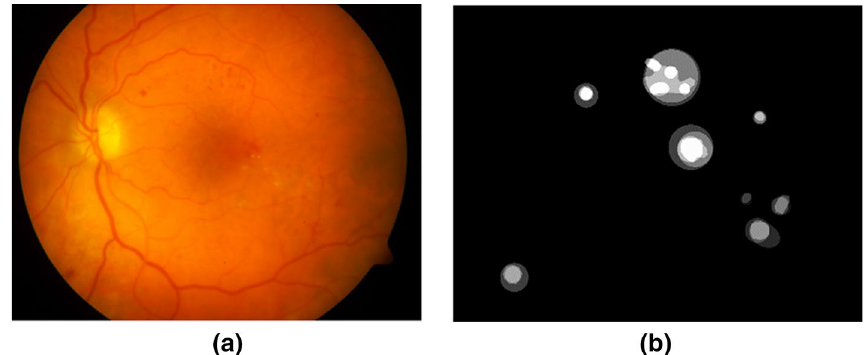
Fig. 9 a Examples of a fundus image with retinal hemorrhages from the DIARETDB1 database and b ground truth examples of retinal hemorrhages from the DIARETDB1